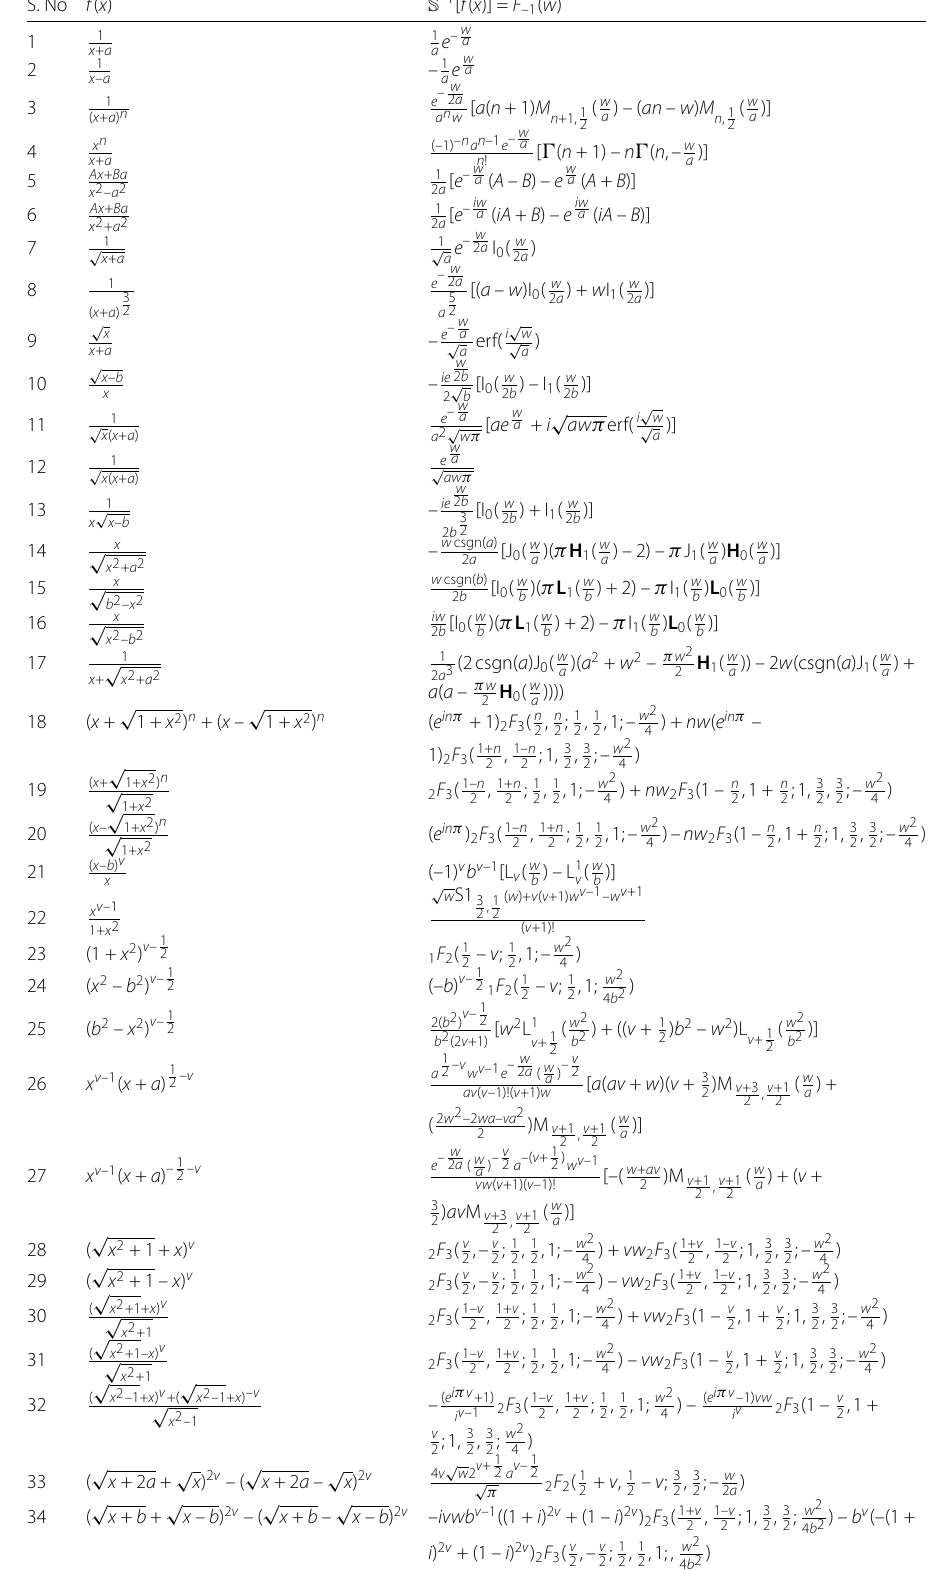
Table 1 Inverse Sumudu transform of elementary